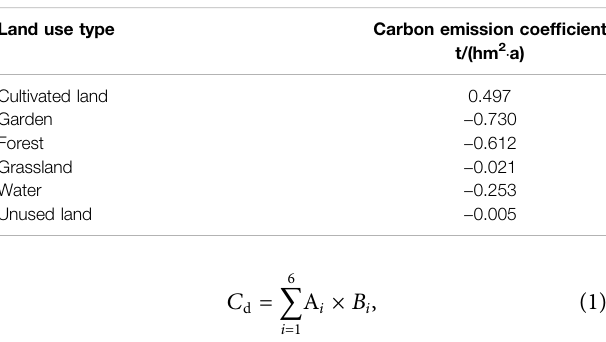
TABLE 1 | Carbon emission coef fi cients in Ningxia.